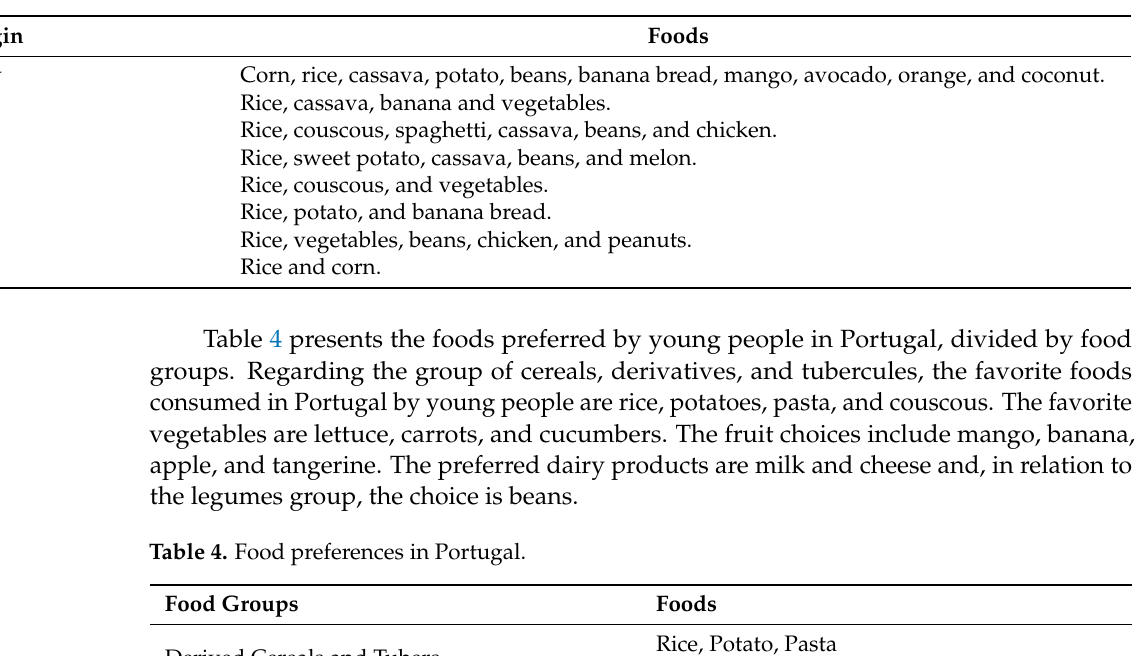
Table 3. Food preferences in the countries of origin.